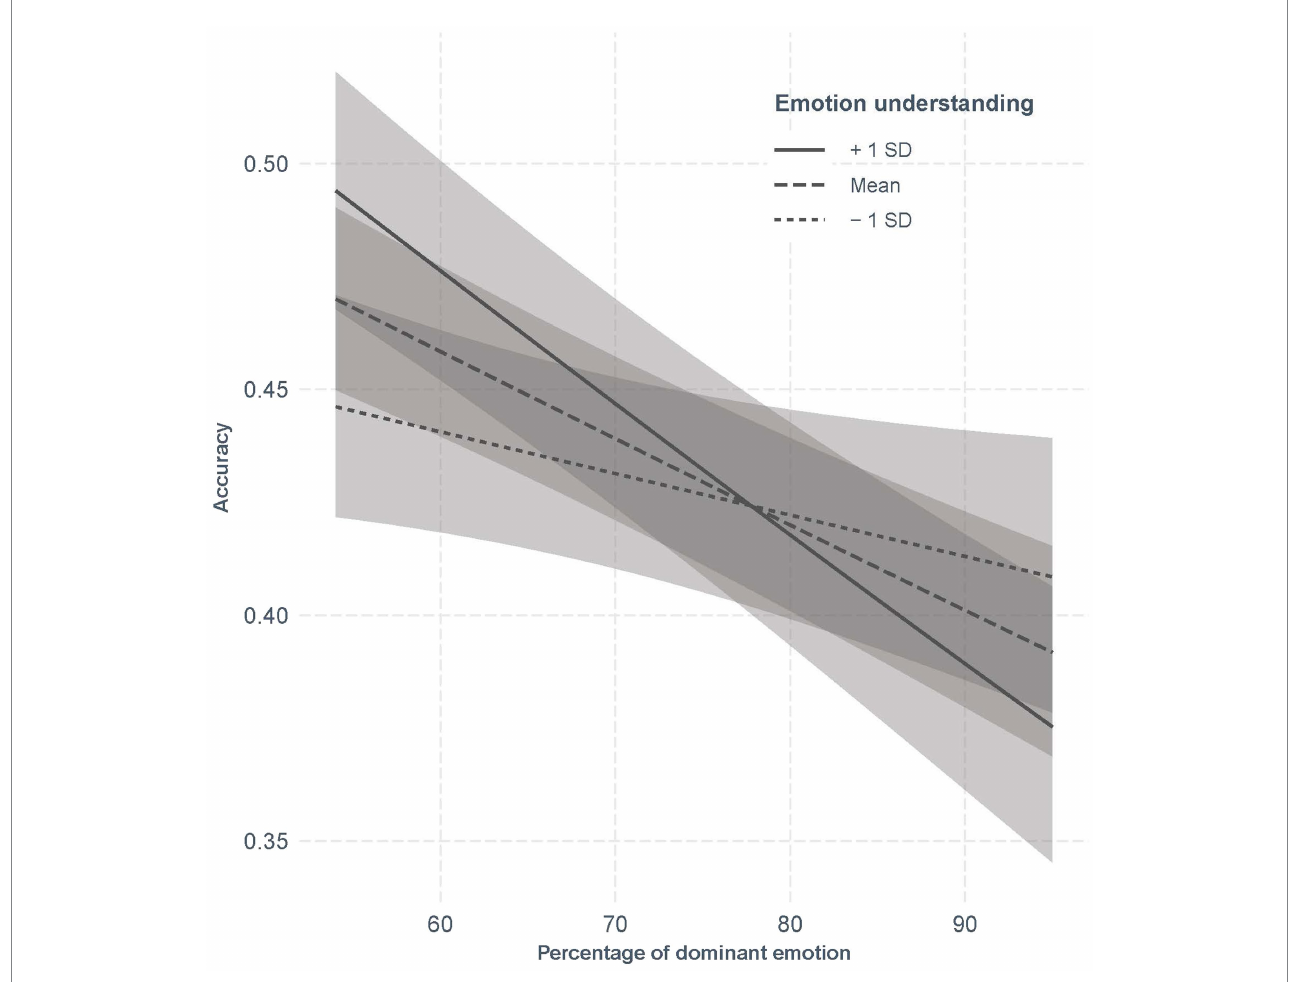
FIGURE 5 Accuracy in the task in function of emotion understanding and percentage of dominant emotion in emotion